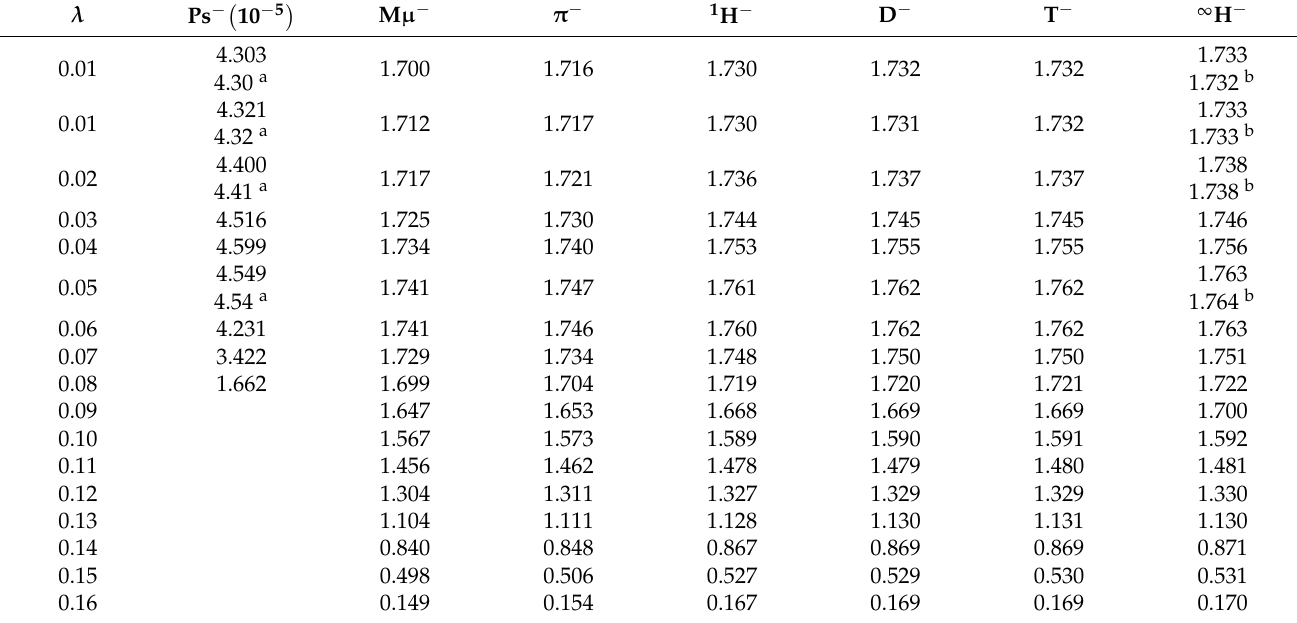
Table 2. 1 S e resonance widths Γ values of the parameter λ